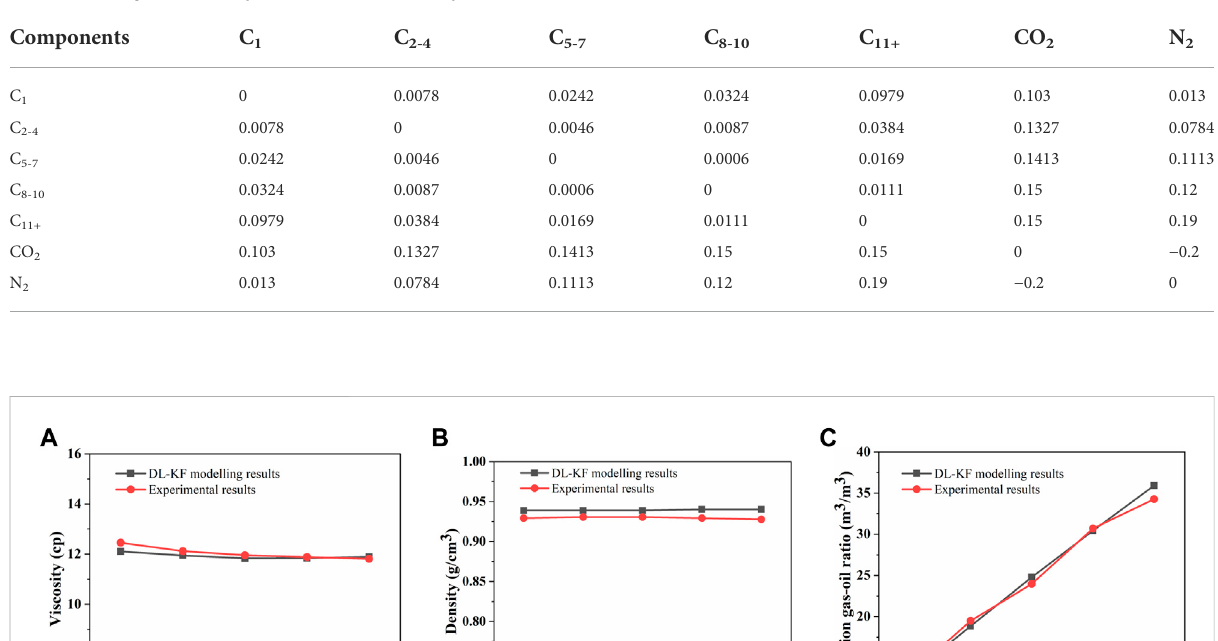
TABLE 10 Binary interaction parameters for fl uid components.